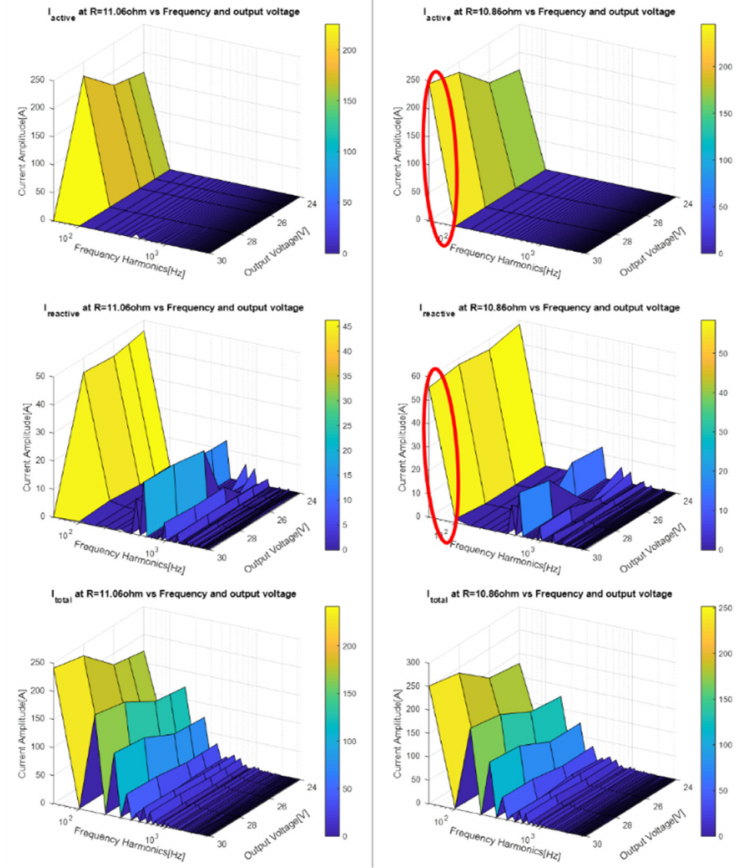
Figure 24. Loaded AC/DC converter with fixed 11.06 Ω output resistance vs. 10.86 Ω output resistance, variable output voltage ( V ) —active, reactive, total current. Differences are marked with red ellipses (currents are not normalized). Only amplitude graphs are